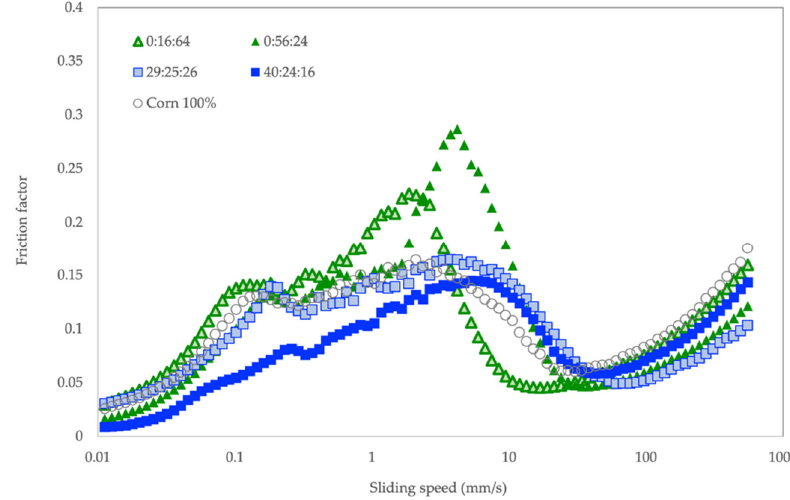
Figure 7. Friction factor at different sliding speeds for selected extrudate formulations with different proportions of flours (%okara: %mung bean: %rice).